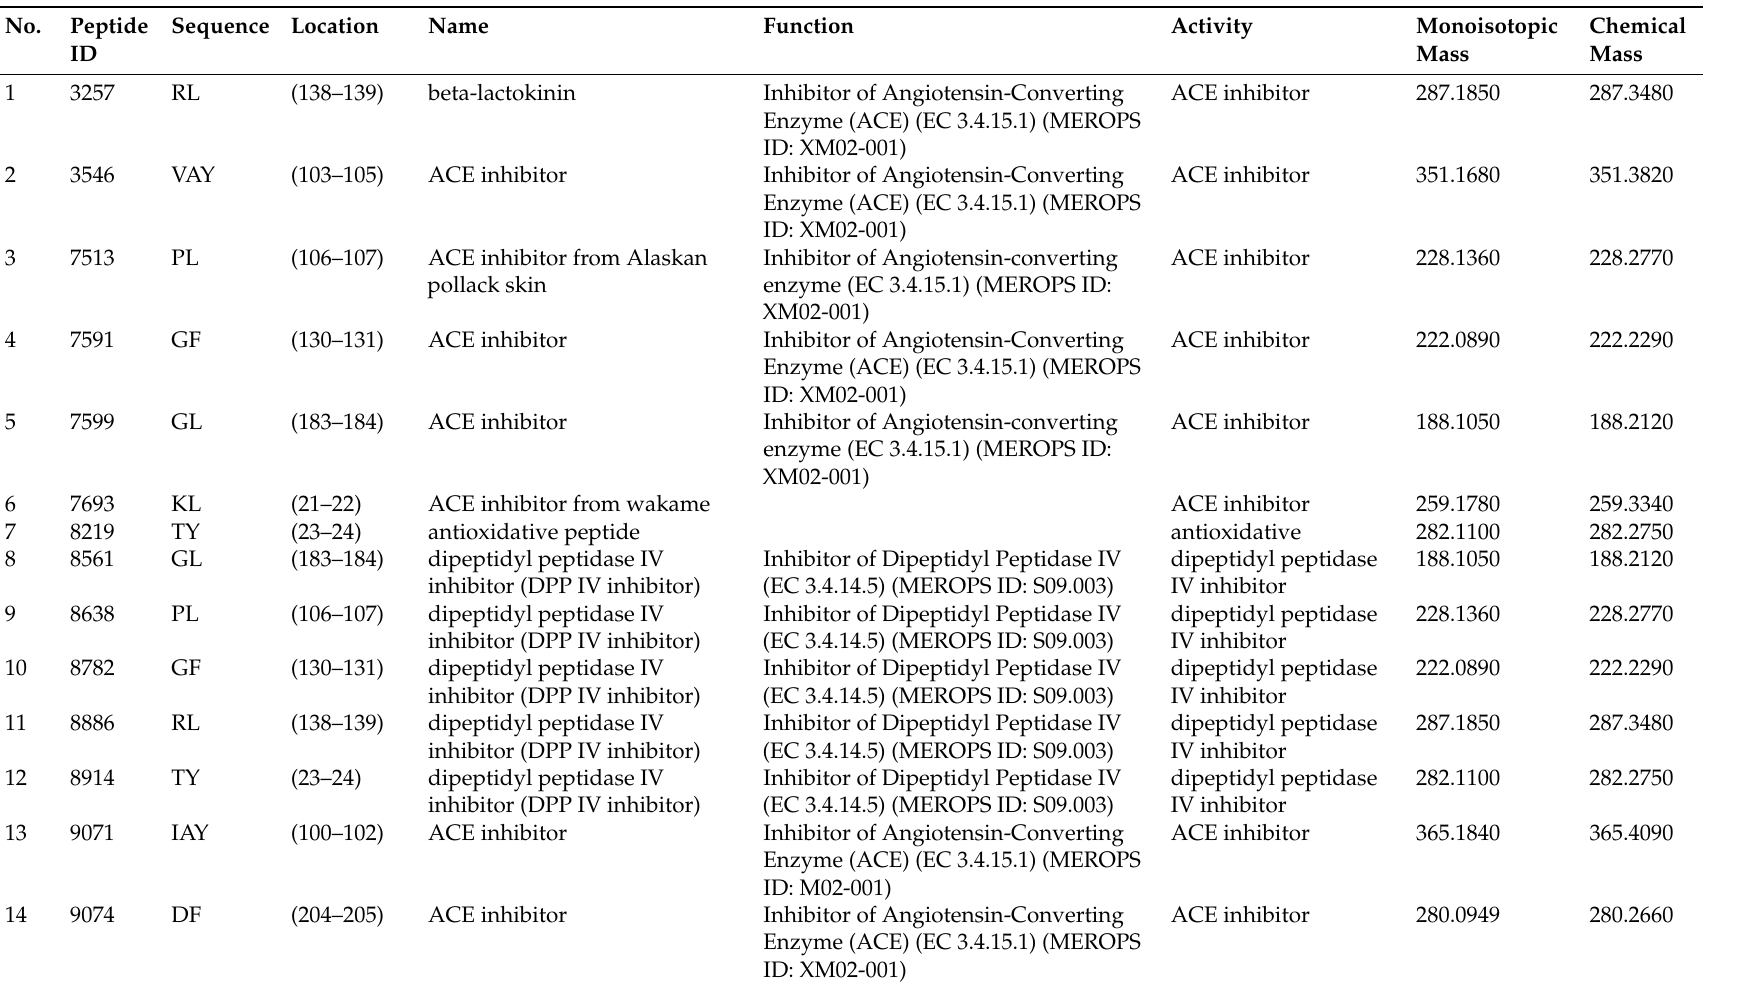
Table A25. Bioactive peptides from RubisCO of Halophila stipulacea . In silico enzymatic cleavage was carried out by using